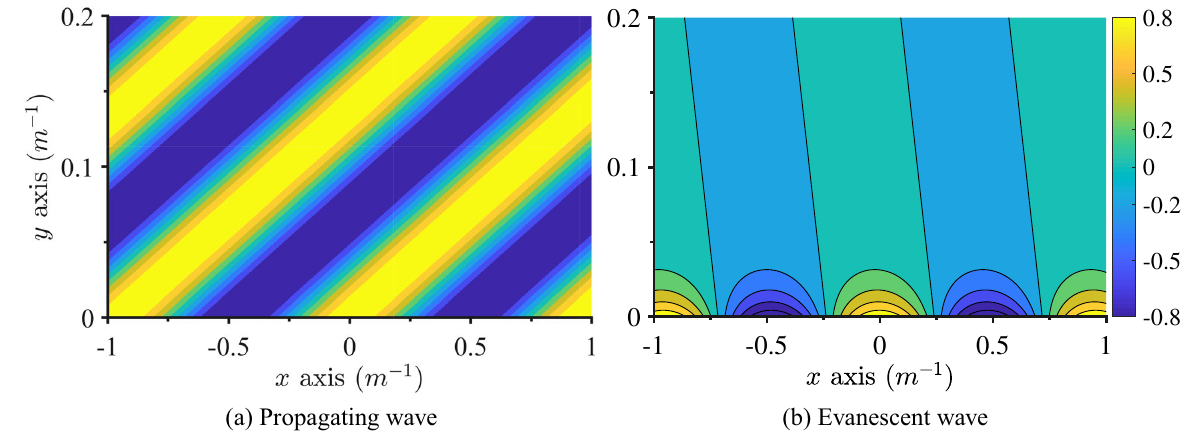
Figure 3. Contour plot of the real part of the out-of-plane displacement produced by the outgoing propagating ( a ) and evanescent ( b ) bending waves in a 45 ◦ / − 45 ◦ / 45 ◦ / − 45 ◦ / 45 ◦ composite plate plotted in the ( x , y ) plane. Brighter colours represent positive z values, whilst darker ones denote negative z values.